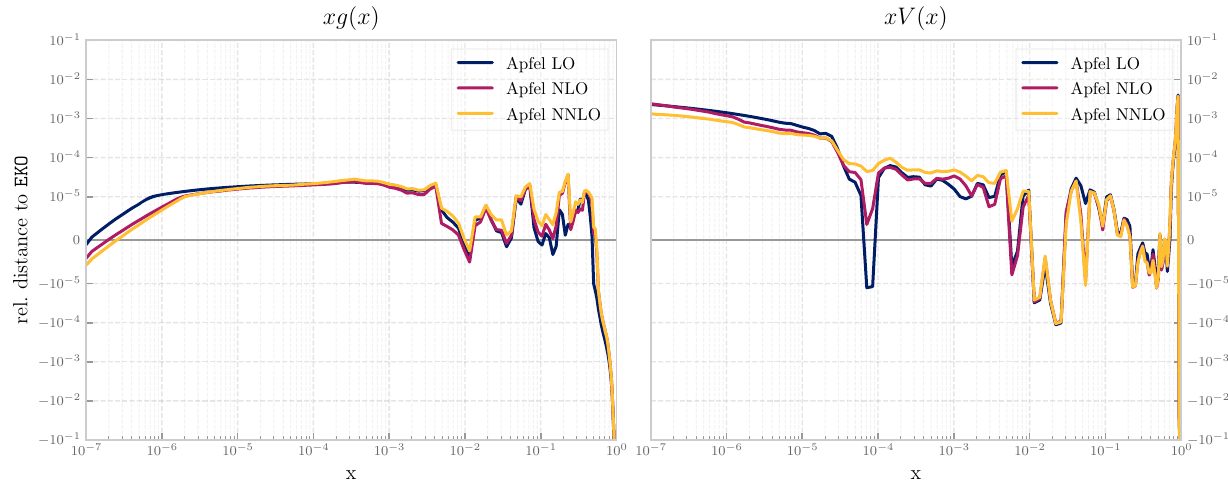
Fig. 2 Relative differences between the outcome of evolution as implemented in EKO and the corresponding results from APFEL at different perturbative orders. We adopt the same settings of Fig. 1